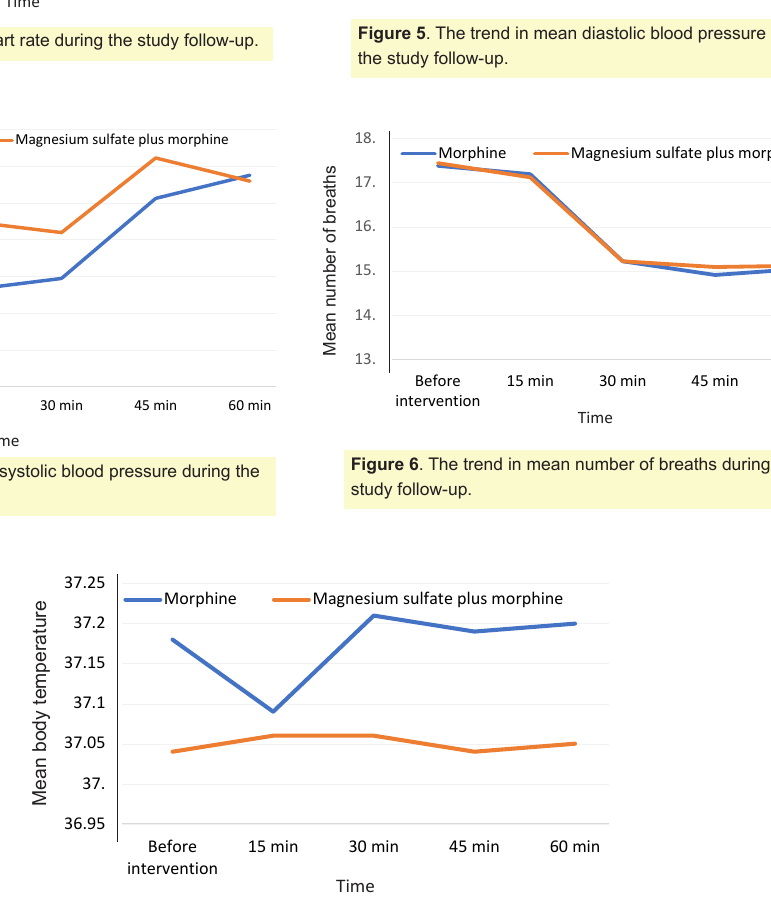
Figure 7 . The trend in mean body temperature during the study follow-up.